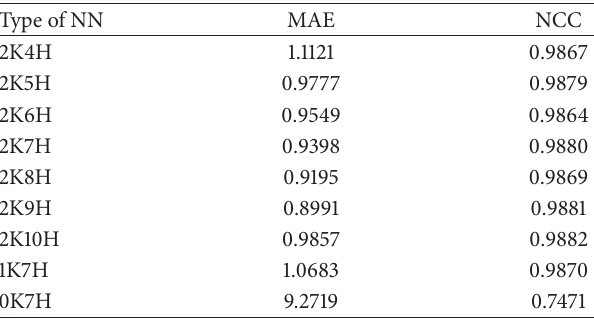
Table 6: Error in different hidden and knowledge neurons of papilionaceous dual-plane